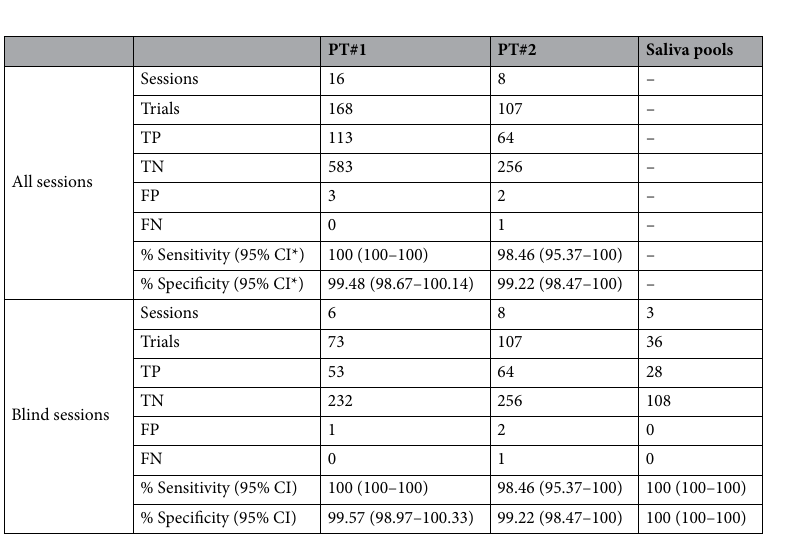
Table 7. Detection of saliva samples from osteosarcoma patients by Dog#1. *Confidence interval calculated with the values obtained in the different